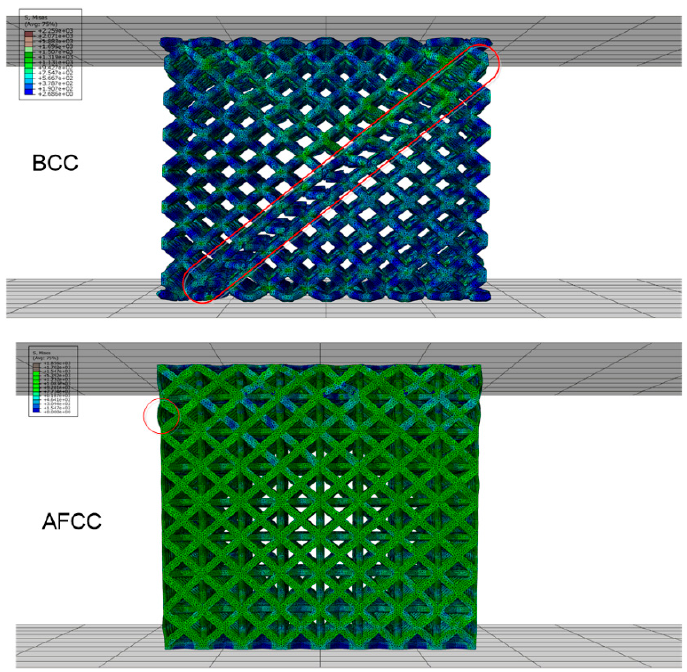
Figure 8. Failure diagram of AFCC and BCC lattice structures.